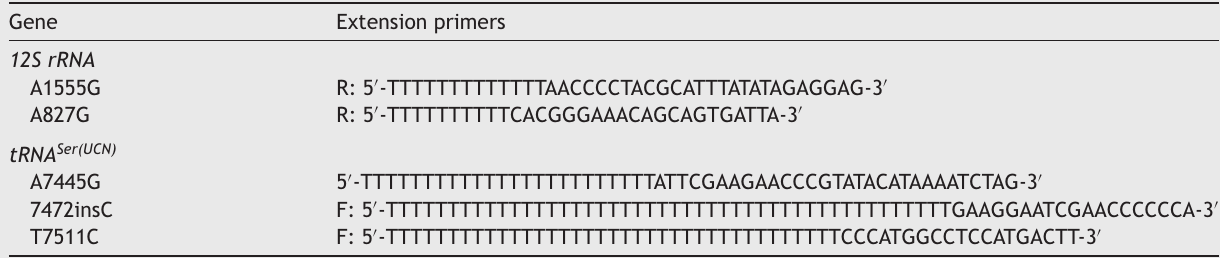
Extension primer